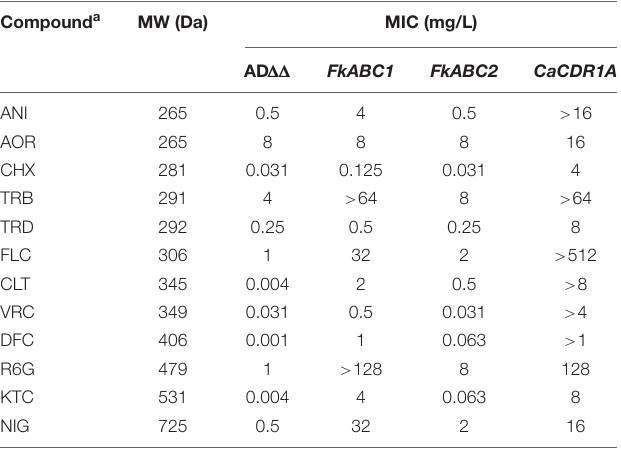
TABLE 6 | Drug susceptibilities of S. cerevisiae AD (cid:49)(cid:49) (control) and AD (cid:49)(cid:49) cells overexpressing FkABC1 , FkABC2, or CaCDR1A . Compound a